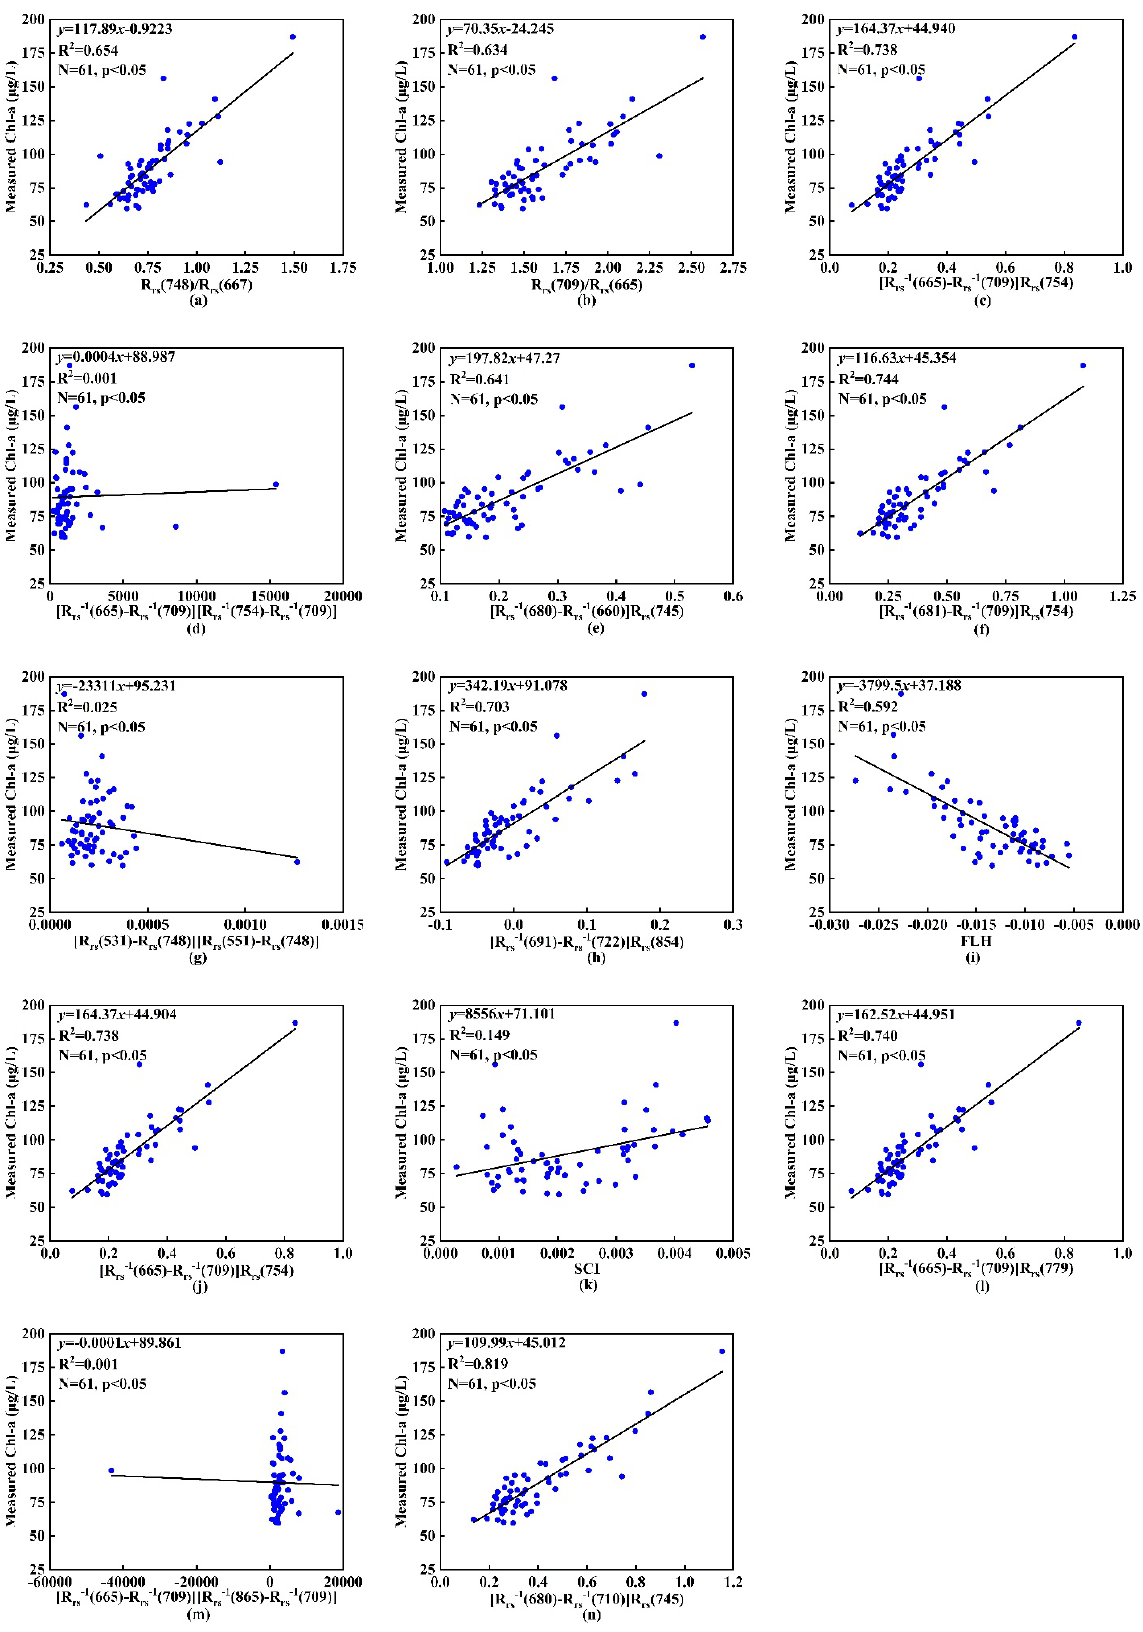
Figure A1. Comparison of existing Chl-a concentration retrieval algorithms based on measured data. ( a – n ) are the models reconstructed by applying the algorithms in Table A2 to Dianchi Lake through calibration parameters.